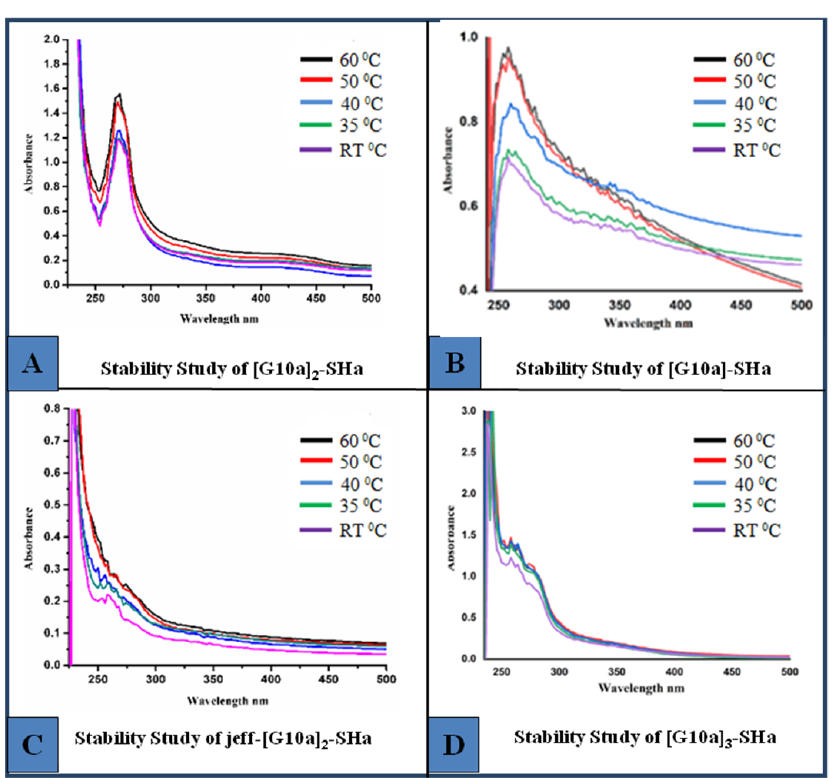
Figure 6. Stability studies of monomer and dendrimer peptides ( A ) [G10a] 2 -SHa ( B ) [G10a]-SHa ( C ) Jeff-[G10a] 2 -SHa ( D ) [G10a] 3 -SHa at different temperatures ranging from room temperature, 35 ◦ C, 40 ◦ C, 50 ◦ C and 60 ◦ C.